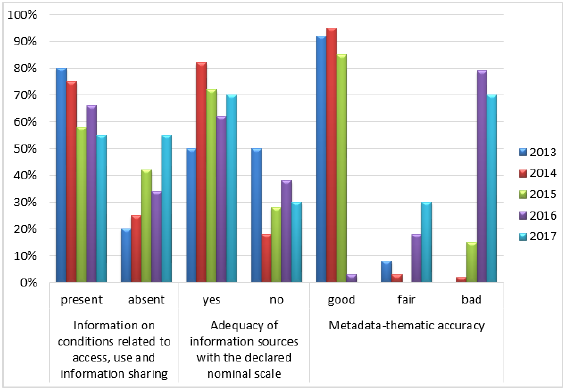
Figure 4. Evolution of quality parameters over time